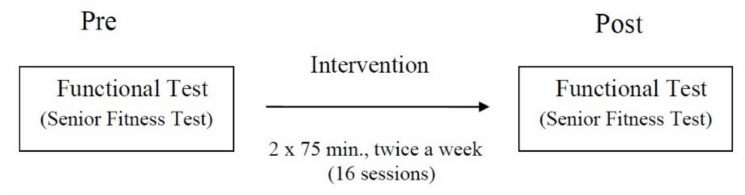
Figure 2. General overview of the